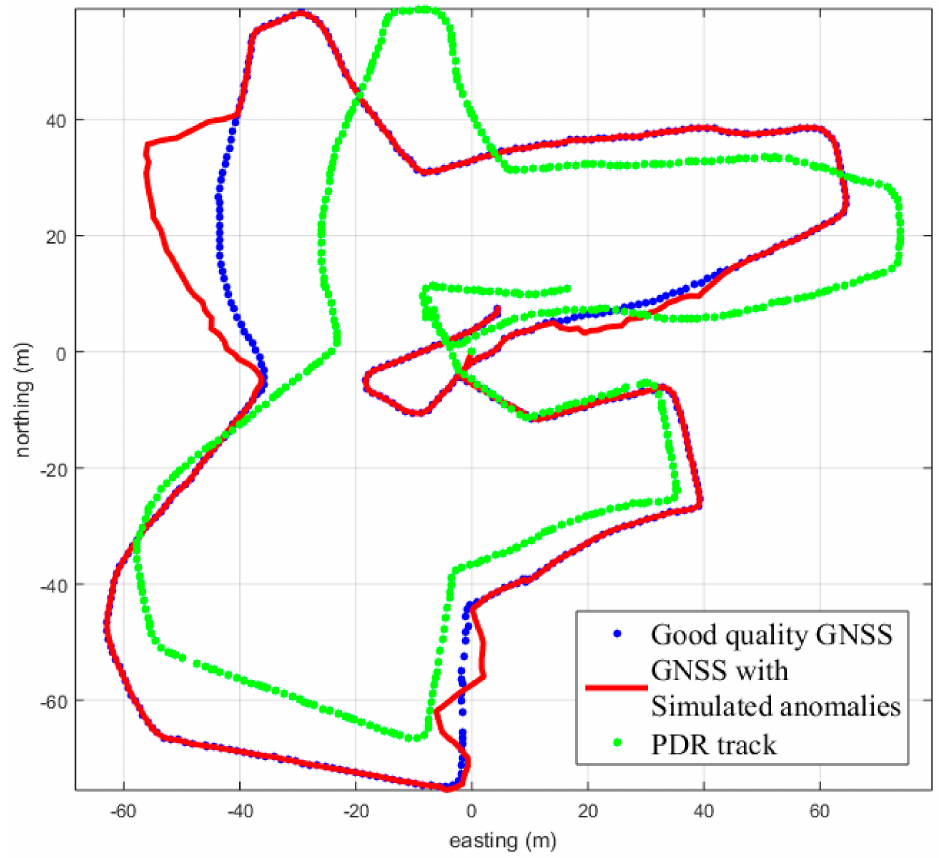
Figure 3. The red track shows the added simulated GNSS trajectories. The blue one is the original good-quality GNSS track. The green track shows the PDR trajectory, which is compared with the GNSS tracks with